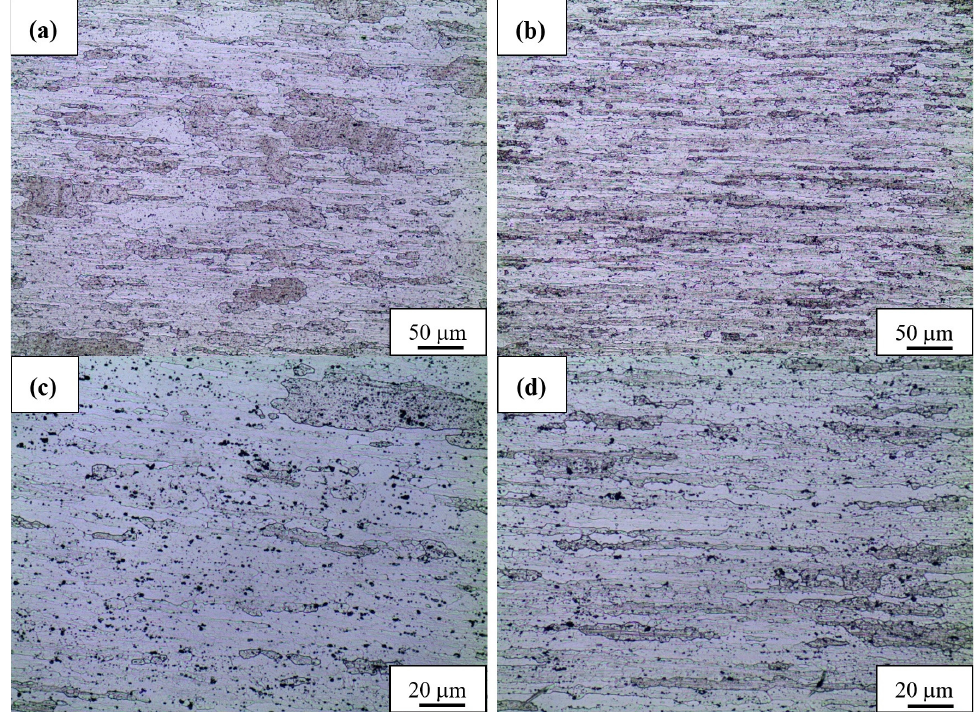
Figure 5. Microstructure of the N1.6 ( a , c ) and C1.6 sample ( b , d ) with different magnifications.